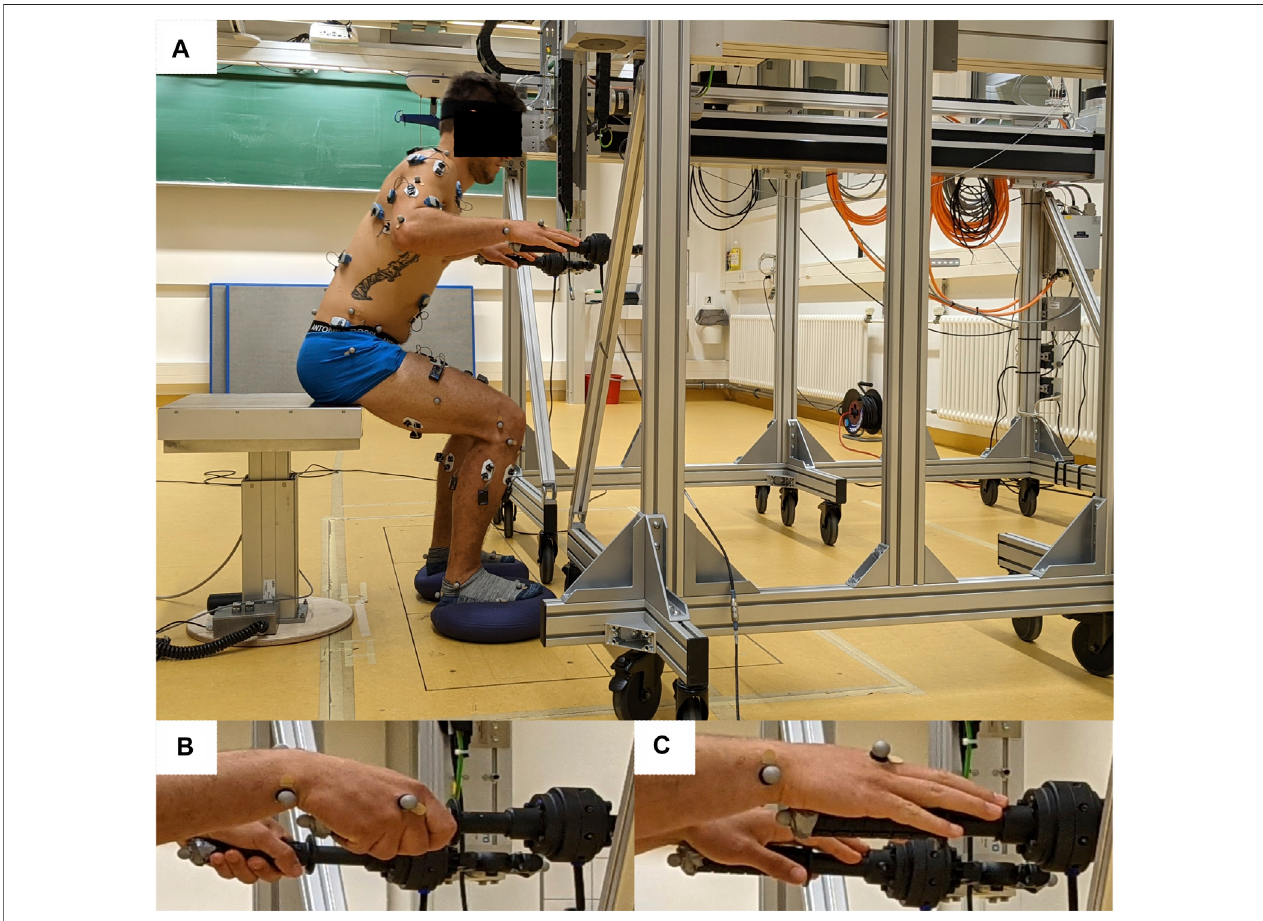
FIGURE 1 | Experimental setup. (A) Male participant standing up with the custom-made robot rollator simulator. A balance-pad was used under each foot to induceunstable fl oorconditionsduringstandingupandsittingdown.Full-bodypassivemarkersformotiontrackingandEMGelectrodes(datanotincludedinthisarticle) were placed on the body. (B) Hand position during full support condition. (C) Hand position under touch